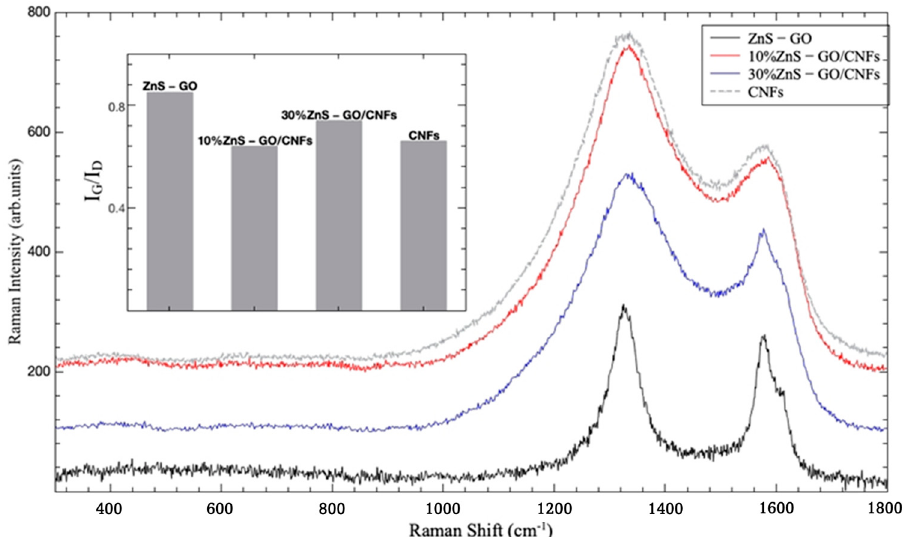
Figure 9. Room temperature Raman spectra for ZnS–GO (black line), 10%ZnS–GO/CNFs (red line) and 30%ZnS–GO/CNFs (blue line), together with the Raman spectrum for starting CNFs (gray line). In the inset, the intensity ratio (I G /I D ) is reported for the same samples.